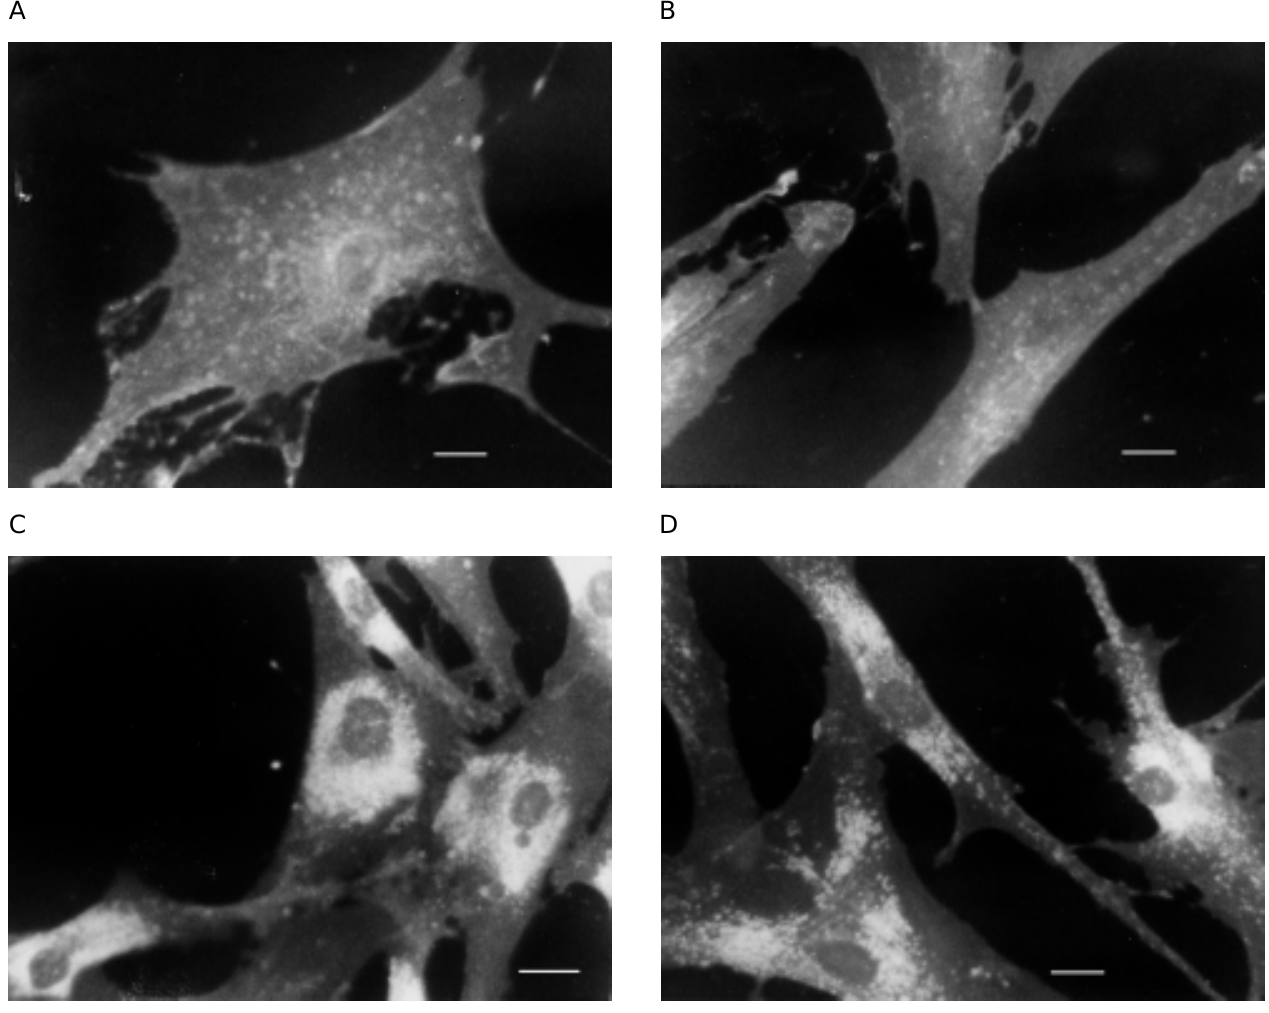
Figure 1 - Normal and Niemann-Pick type C fibroblast cultured with LDL for 24 h with or without DMSO. Cultures were stained with Filipin for fluorescence visualization of unesterified cholesterol. A , Normal fibroblasts incubated with 50 µg/ml LDL alone; B , normal fibroblasts incubated with 50 µg/ml LDL and 2% DMSO; C , Niemann-Pick type C fibroblasts incubated with 50 µg/ml LDL alone; D , Niemann-Pick type C fibroblasts incubated with 50 µg/ml LDL and 2% DMSO. Magnification, 40X. The bar corresponds to 25